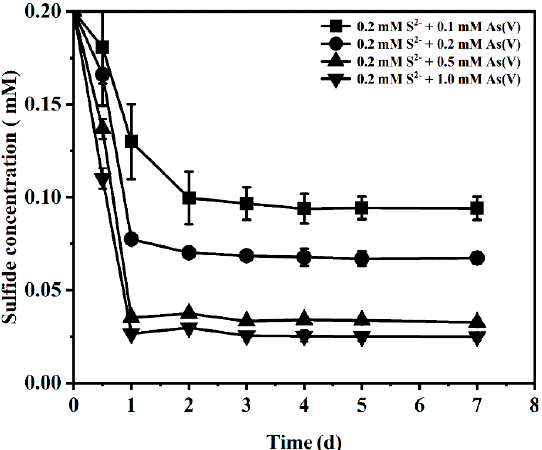
Figure 6. The change in sulfide concentration in the medium under different sulfur-arsenic ratio conditions.